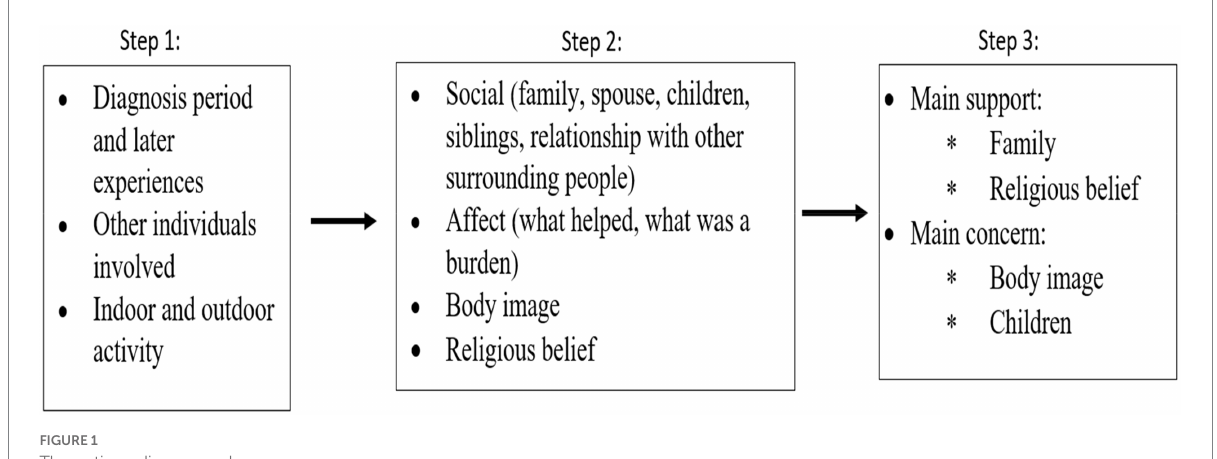
FIGURE 1 Thematic coding